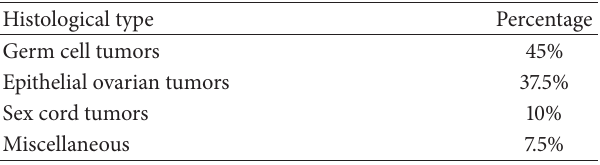
Table 1: Malignant types of adnexal masses in pregnancy